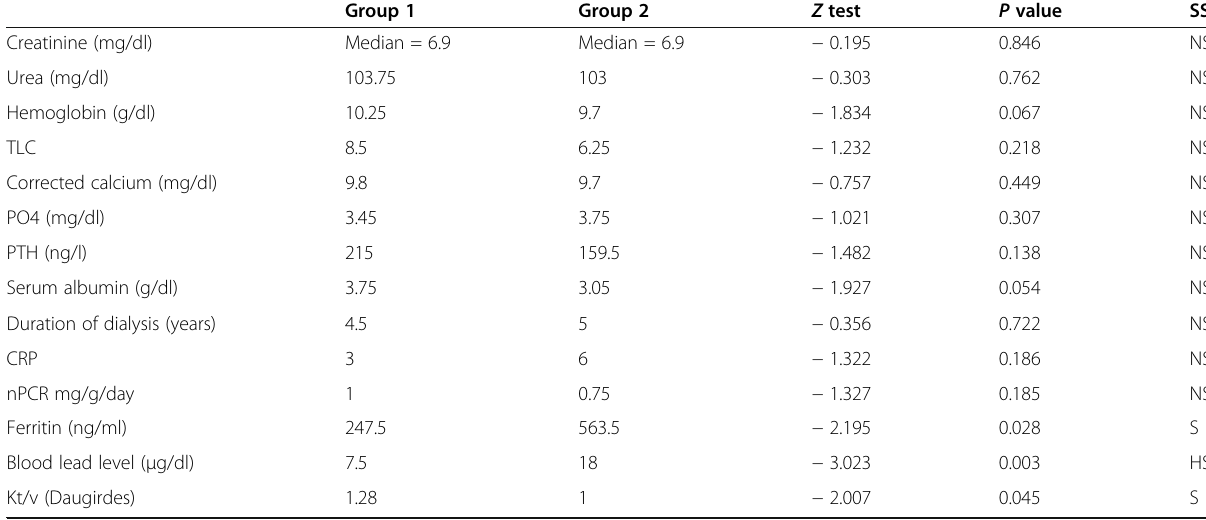
Table 2 A comparison between 2 groups (with and without uremic pruritus) as regards laboratory data where NS = non-significant, SS = statistically significant, and HS = highly significant Group 1